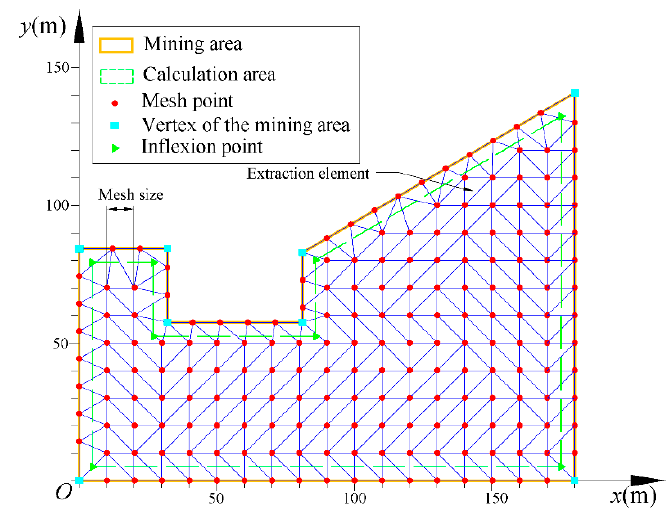
Figure 3. Example of segmentation result of an irregularly shaped mining area using DTM.